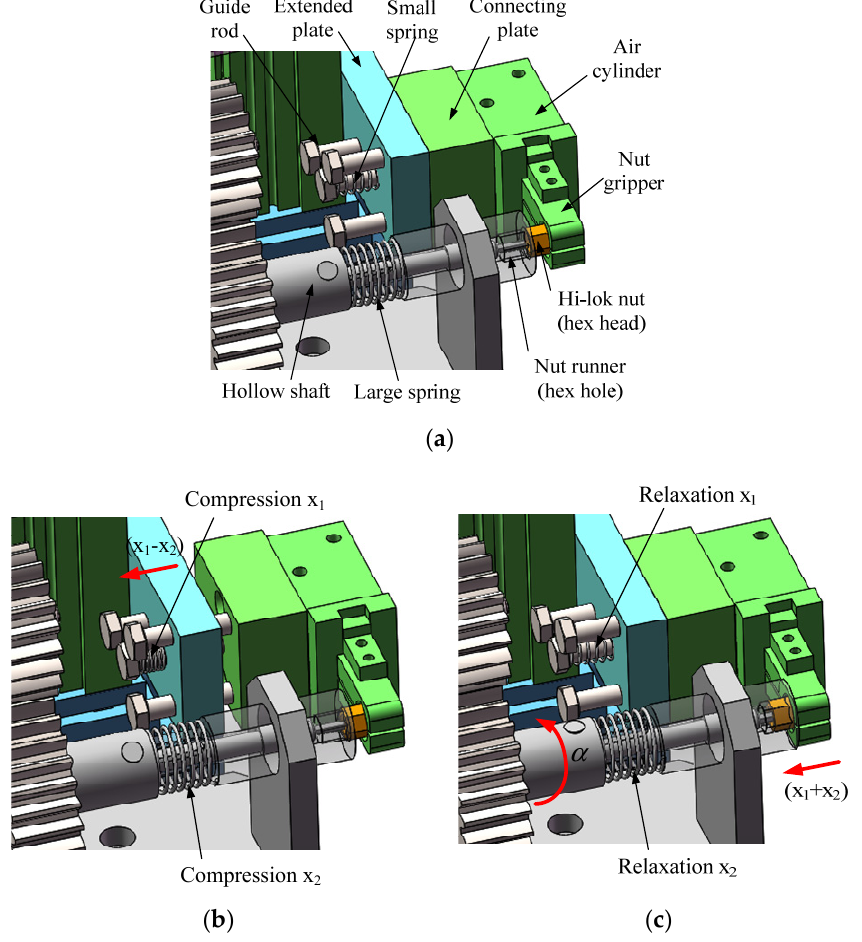
Figure 8. Structure and aligning principle of FA device, ( a ) Before compression ( b ) Spring compression ( c ) Aligning successfully.